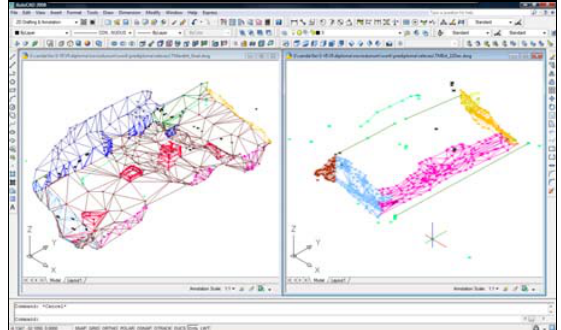
Figure 8. Interior (left) and exterior (right) views of the 3D model of the Large Tower , as resulted from PhotoModeler . Different colored layers are meant to ease working with